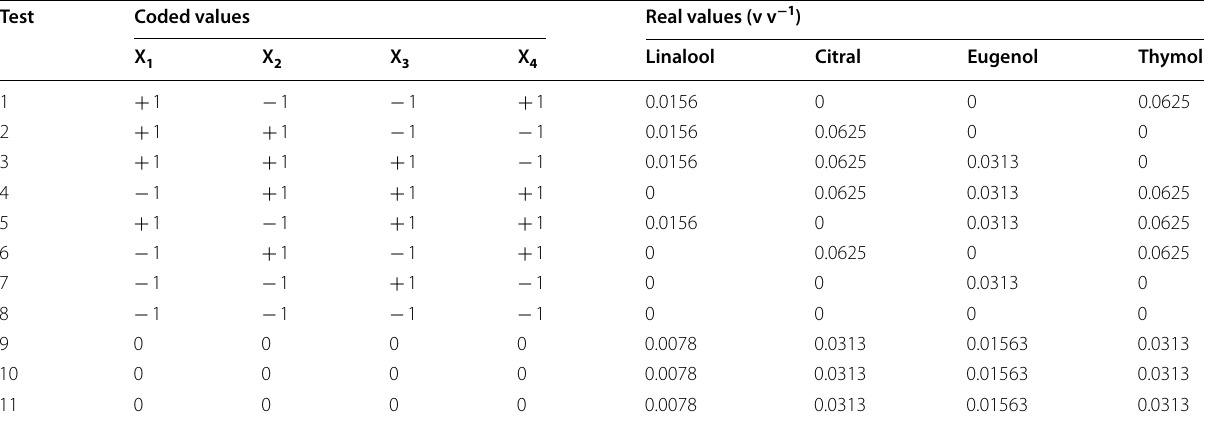
Table 1 Plackett & Burman 8 matrix containing coded and real values